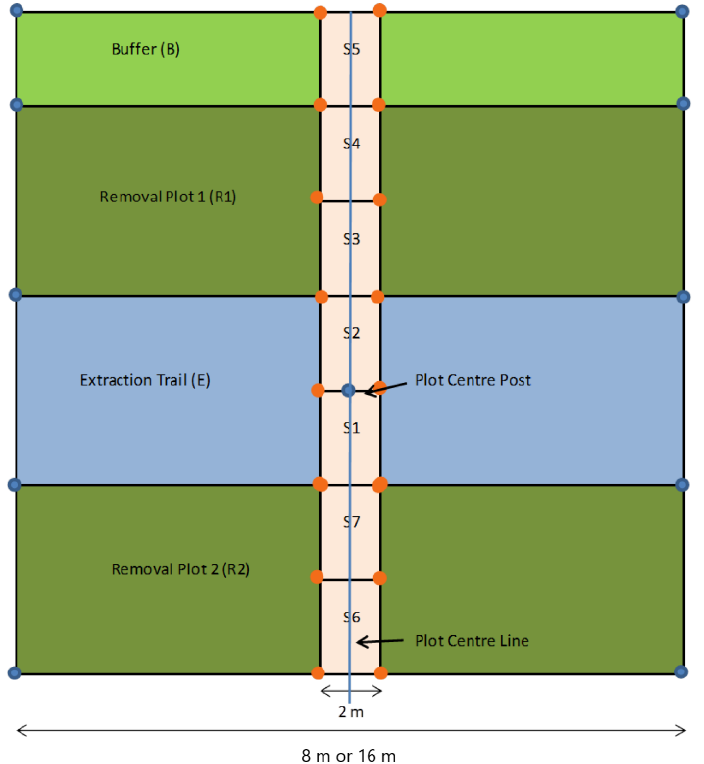
Figure 2. General layout of SCUP plot cluster (S1–S7 are sapling subplots). Plot length is 8 or 16 m and widths vary with width of each SCUP treatment. Total plot cluster sizes range between 150 m 2 and 463 m 2 .